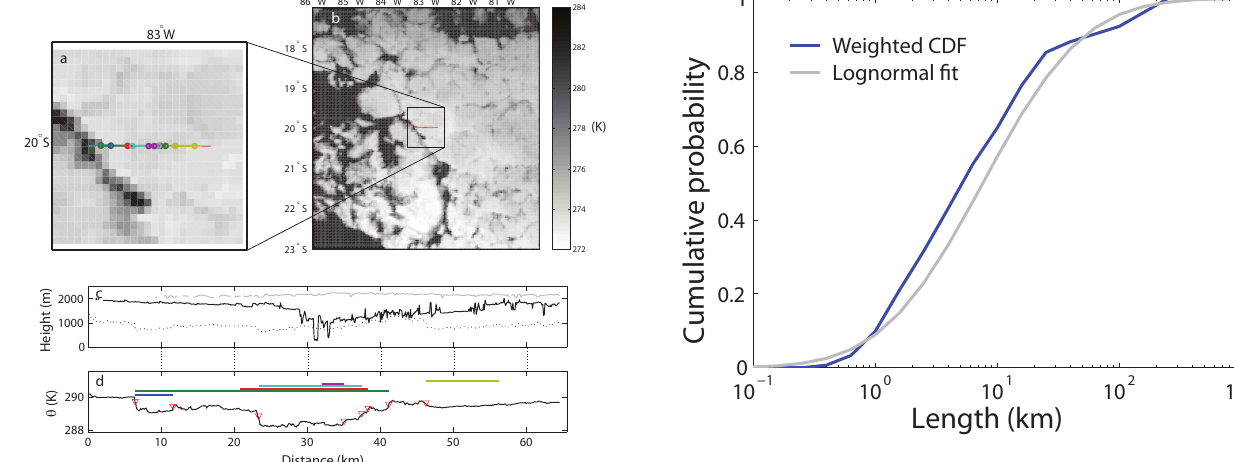
Fig. 4. Cumulative distribution of the observed cold-pool size (blue), where each cold pool is weighted using Eq. (5). Note that the x axis is log-scale and size bin widths are equal in log-space. The log-normal fit (mean of the natural logarithm µ = 2 . 45 and standard deviation of the natural logarithm σ = 1 . 25) based on the weighted data is plotted in